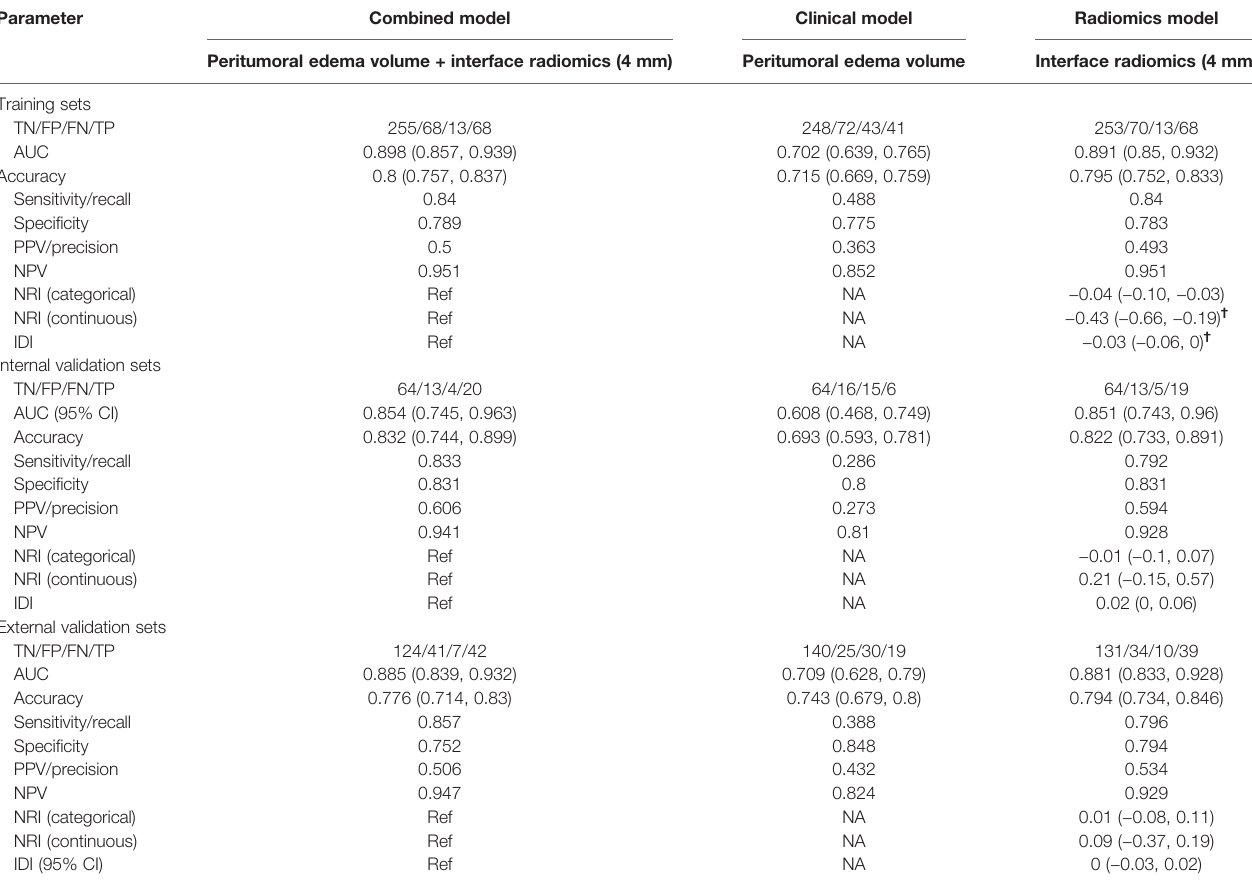
TABLE 2 | Diagnostic performance of classi fi ers. Parameter Combined